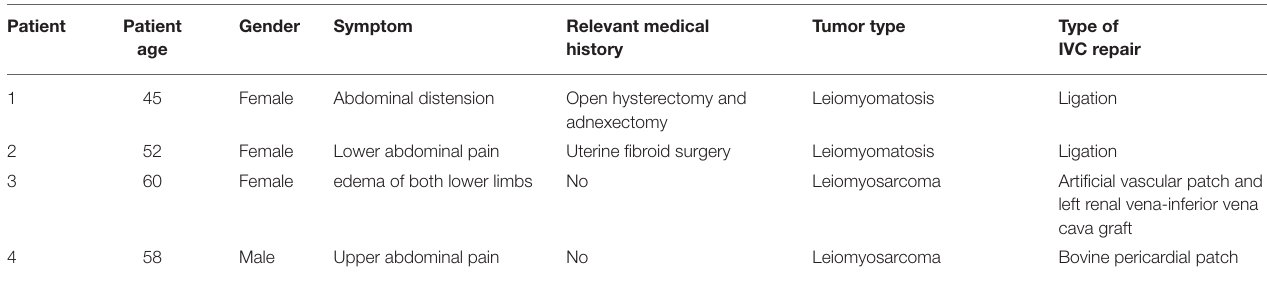
TABLE 1 | Overview of